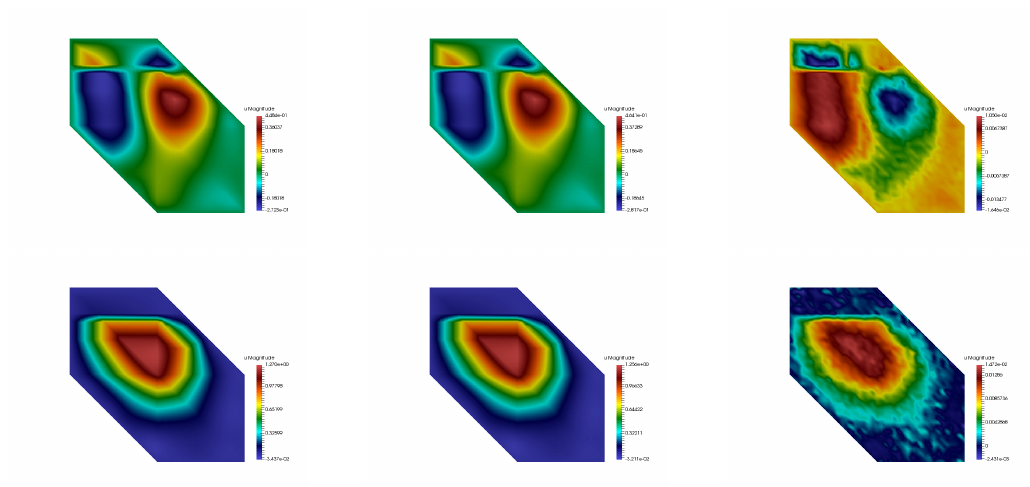
Figure 7. Exact multiscale basis functions φ ω 1 m ( left ), predicted multiscale basis functions φ ω 1 ,pred m ( middle ) and their differences ( right ) in the coarse neighborhood ω 1 in experiment 2. The first row and the second row illustrate the first basis function φ ω 1